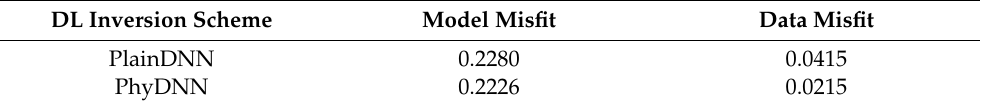
Table 2. Mean model and data misfits of the test set for the PlainDNN and